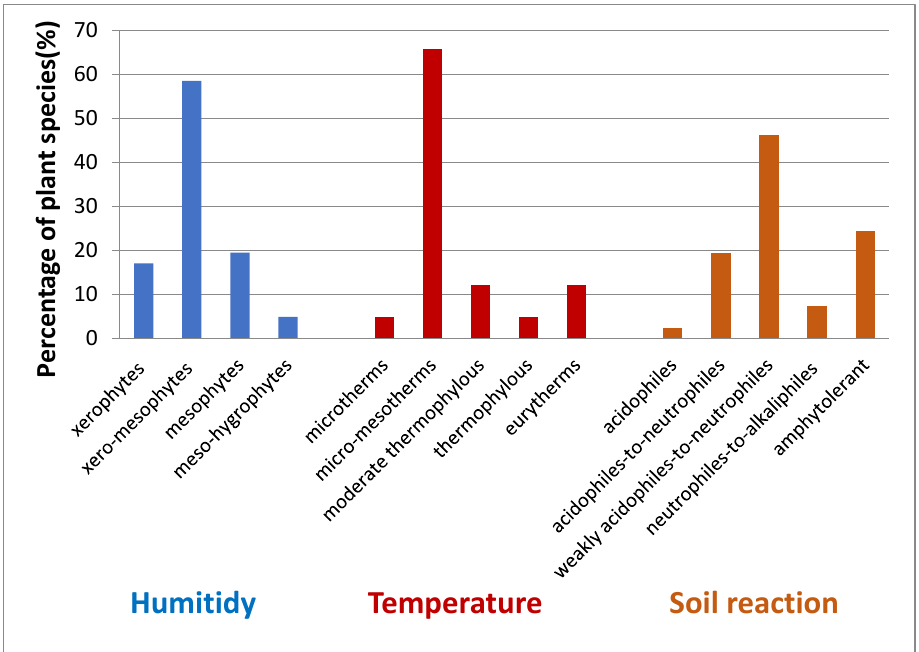
Figure 6. The ecological perspective of investigated vegetation in Natura 2000 ROSCI0295 Dealurile Clujului Est (Jucu de Sus).